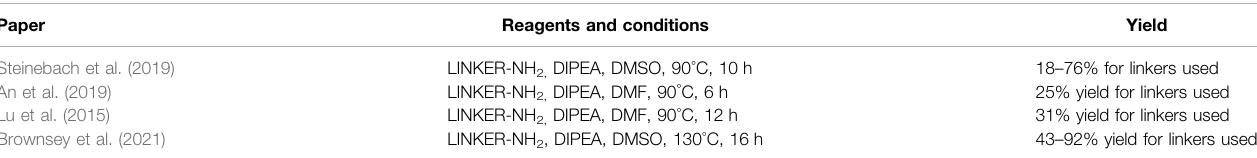
TABLE 1 | Reagents, conditions, and yields for converting compound 5 to 7 ( Scheme 1 , step